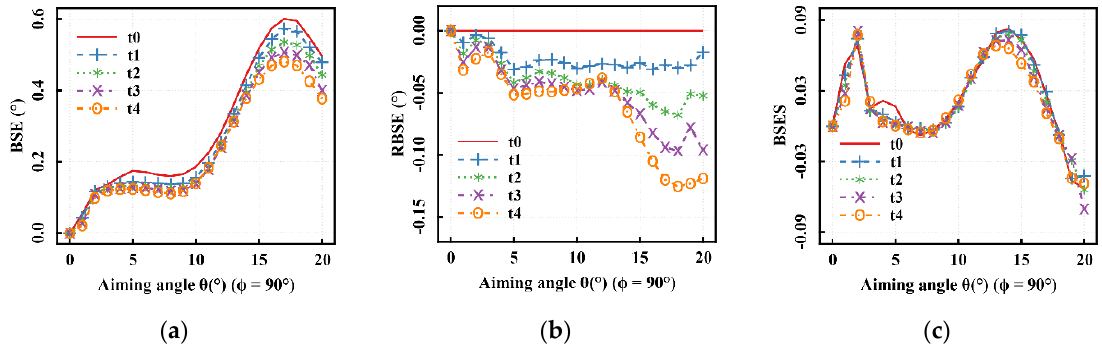
Figure 5. Five ablating moments of the ARS mentioned above are simulated using P − MoM. The BSE, RBSE and BSES at the five moments are calculated to examine the influence of ablation on ARS performance: ( a ) BSE; ( b ) RBSE; ( c ) BSES. In Figure 6, the overall difference patterns for the antenna without radome (red line), antenna with intact radome (blue dot) and antenna with defected radome (green dot) at t4 and θ = 18 ◦ are displayed. A zoomed-in look of the valley region is given in the inset, which shows the obvious differences between one another. It can be seen from the inset that the ablation makes the zero-depth about 1 dB deeper and the BSE 0.13 ◦ smaller than the original ARS. These small variations are meaningful for real engineering applications.